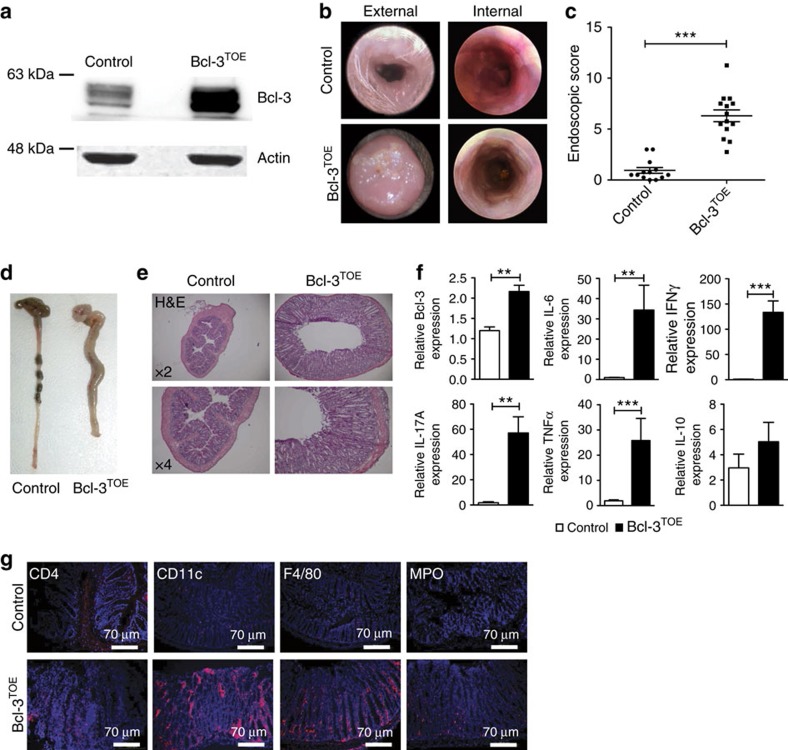
Bcl-3TOE cells cause spontaneous colitis.(a) Western blot analysis of Bcl-3 expression in lysates isolated from T cells of Bcl-3TOE and littermate controls using anti-Bcl-3 antibody. Actin was used as loading control. (b) Representative photographs of colons from Bcl-3TOE and littermate controls at the age of 12 weeks. (c) Mini-endoscopy score of Bcl-3TOE (n=14) and littermate controls (n=13) at the age of 8–18 weeks. Graph displays MEICS scores. Each symbol represents one mouse. Mean±s.e.m. ***P<0.001 using unpaired Student's t-test. (d) Representative macroscopic examination of colons from Bcl-3TOE and littermate controls at the age of 12 weeks. (e) Representative haematoxylin and eosin (H&E) staining of colons from 12 weeks old Bcl-3TOE mice (n=4) and littermate controls (n=4). × 2 and × 4 magnifications are shown. (f) Quantitative RT–PCR of colonic tissues from 12 weeks old Bcl-3TOE mice (n=5) and littermate controls (n=5) for the indicated transcripts. Gene expression levels were normalized to HPRT. Mean±s.e.m. **P<0.01 and ***P<0.001 using unpaired Student's t-test. (g) Representative immunohistochemistry of colonic cryosections from 12 weeks old Bcl-3TOE mice (n=5) and littermate controls (n=5) stained for CD4, CD11c, F4/80 and MPO (red). Nuclei were counterstained with Hoechst 3342 (blue). Scale bars, 70 μm. (a–g) Bcl-3OE littermate mice without Cre were used as controls.